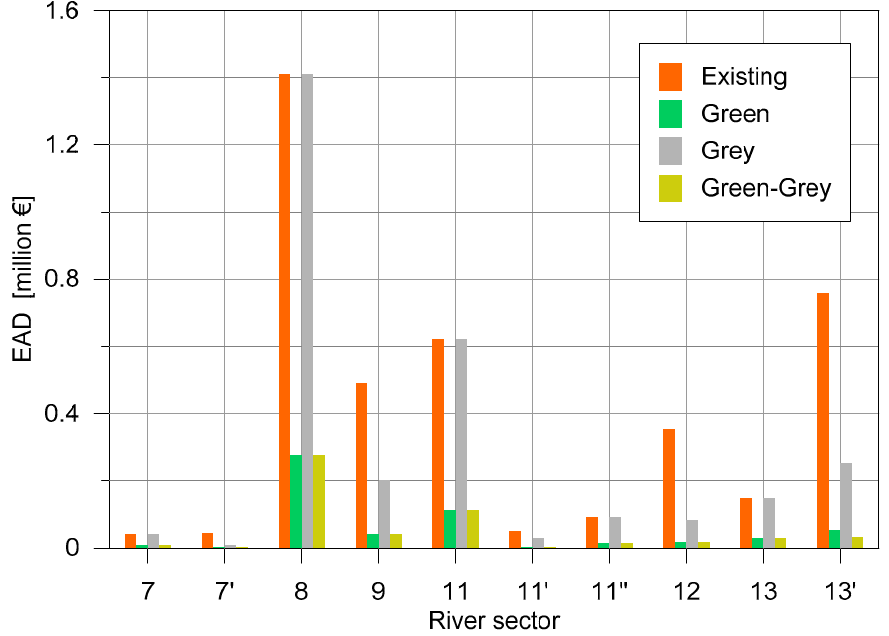
Figure 10. Expected annual damages (EAD) under different flood mitigation scenarios in different river sections across the Tamnava watershed.